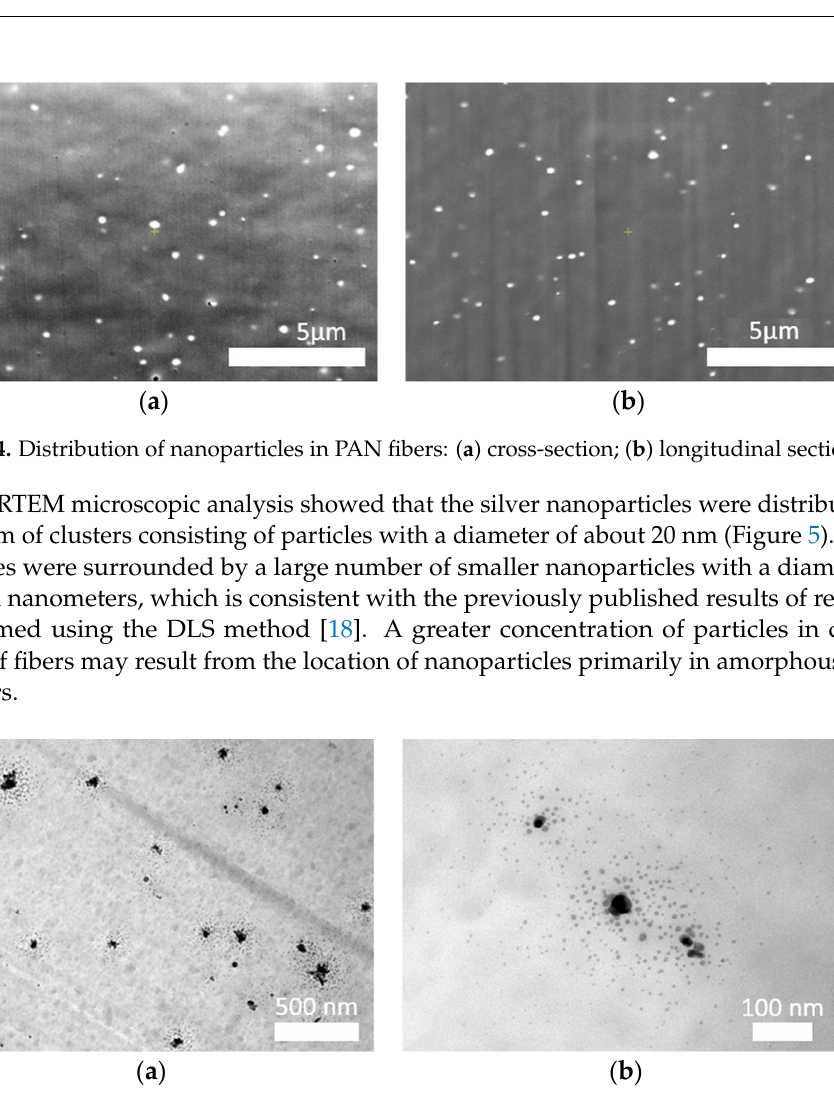
Figure 3. Fiber cross-sections (SEM images): ( a ) non-doped; ( b ) containing AgNPs.